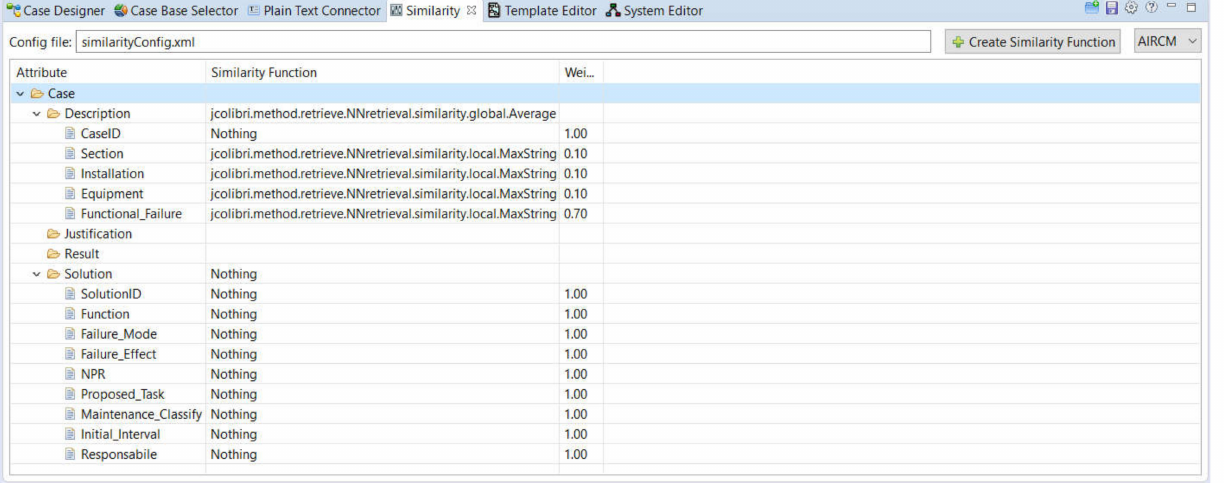
Figure 6. Configuration of the similarity function of the NN method under the jCOLIBRI